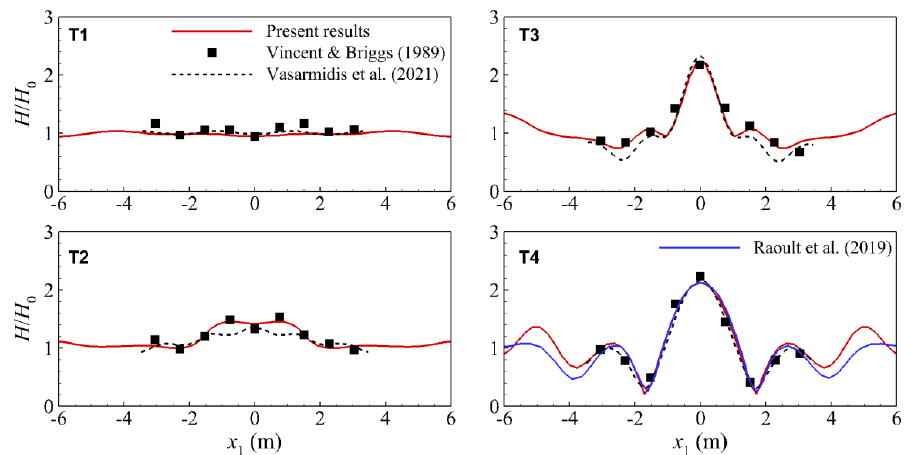
Figure 5. Comparison between present numerical results (red lines), experimental measurements (black squares), and numerical results in the literature (blue line and black dashed line) for the normalized wave height H / H 0 , along the four transects shown in Figure 2, for case C1.